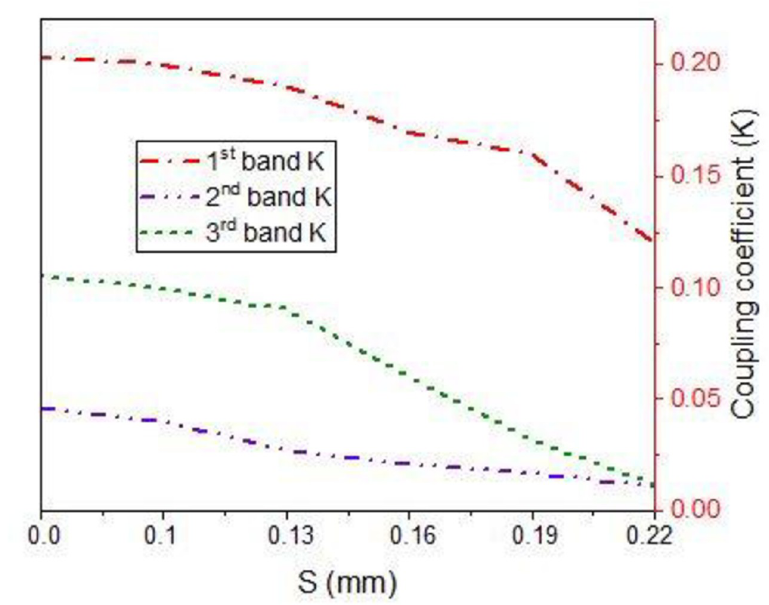
Fig 12. Coupling coefficient “k” against parameter S.